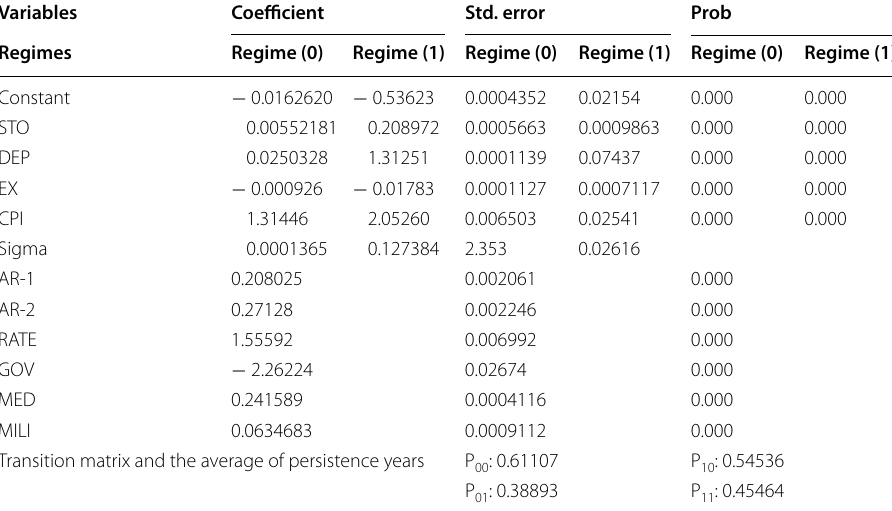
Table 3 The estimation results of equation